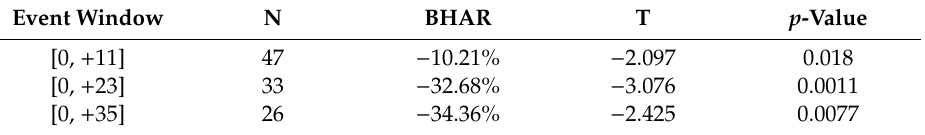
Table 6. Buy-and-hold abnormal returns (BHARs) results in the long term.